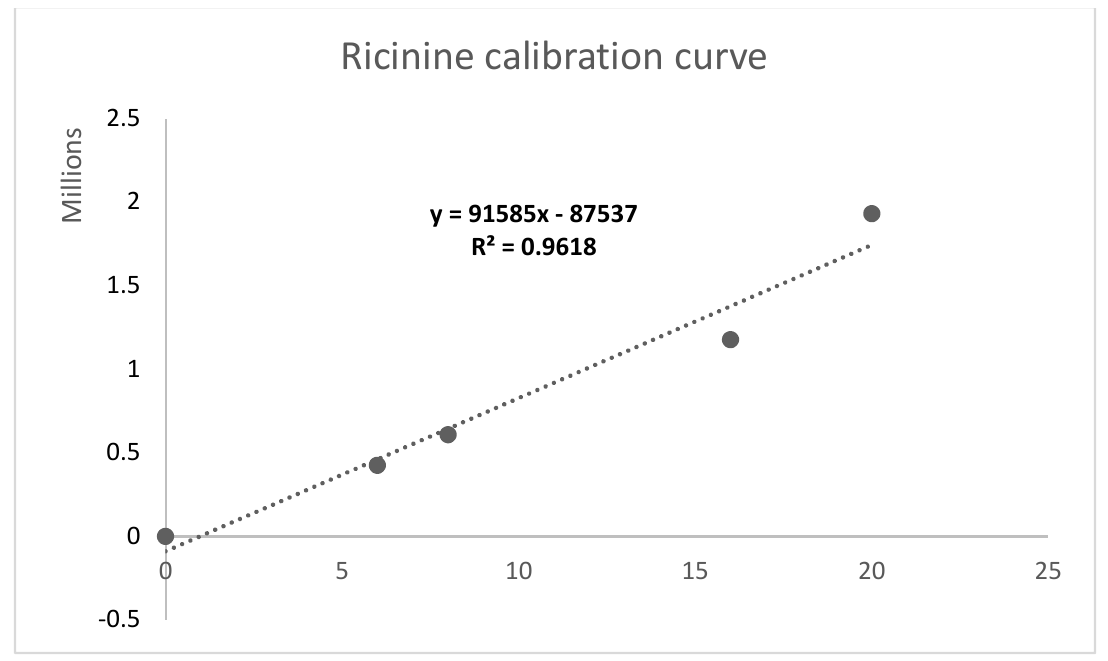
Table 4. Ricinine concentration and area under the curve of the methanolic extracts of R. communis plants treated with salicylic acid. Figure 2. Ricinine calibration curve. Figure 2. Ricinine calibration curve.